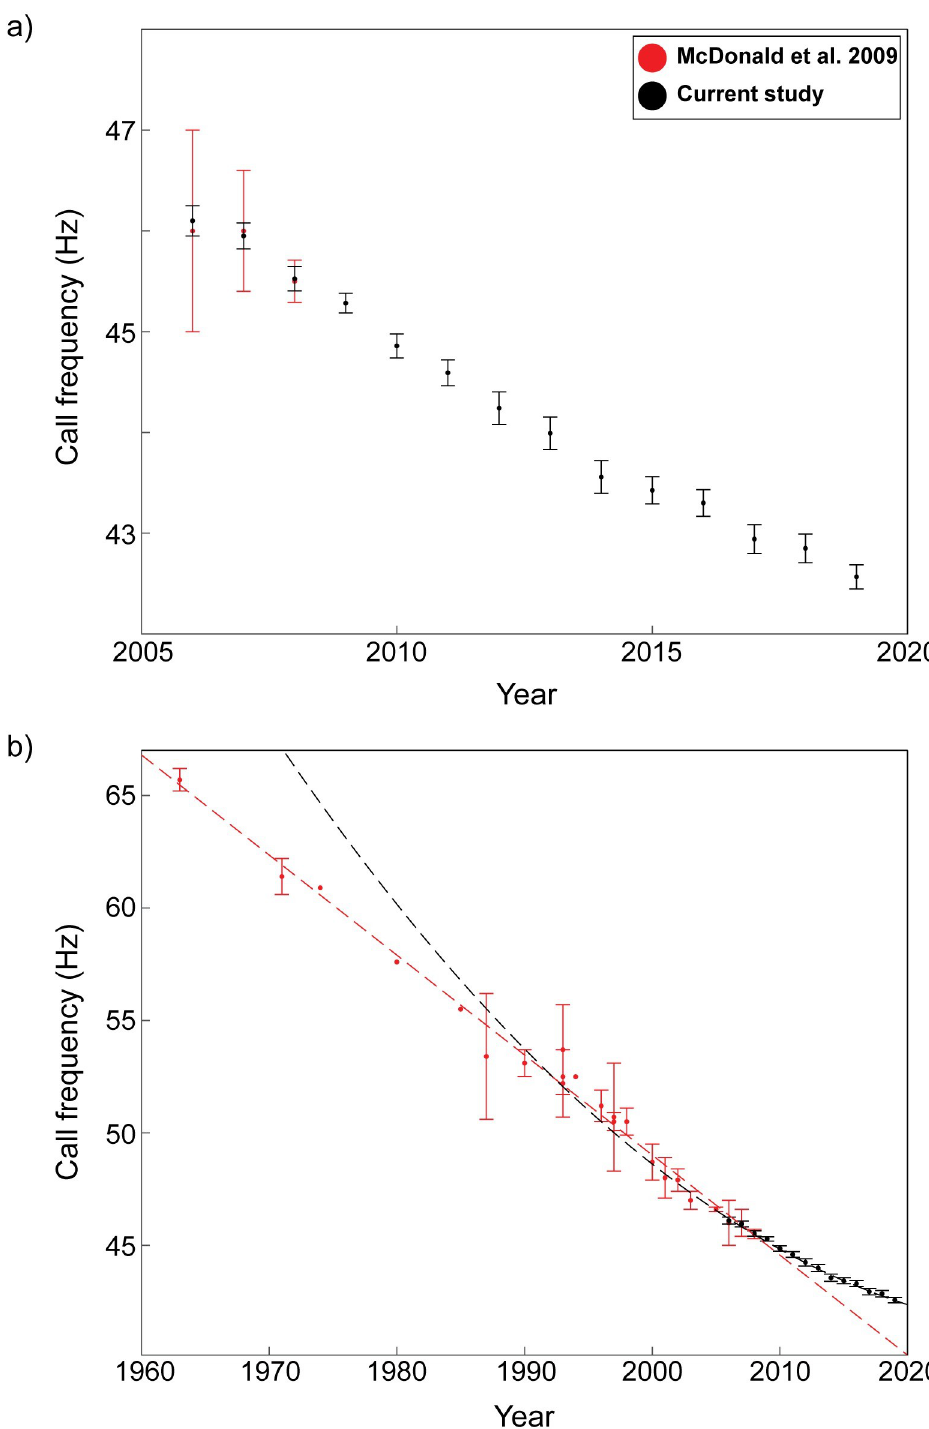
Fig 6. Mean frequencies of Northeast Pacific blue whale B calls. Error bars represent 95% confidence intervals for mean frequencies at 10 th second of the 3 rd harmonic of the calls. Data from McDonald et al . [1] are shown in red and data from the current study in black for (a) 2006 to 2019 and (b) 1963 to 2019. The dashed red line represents a linear fit to data from McDonald et al. [1] and the dashed black line represents the quadratic fit to data from the current